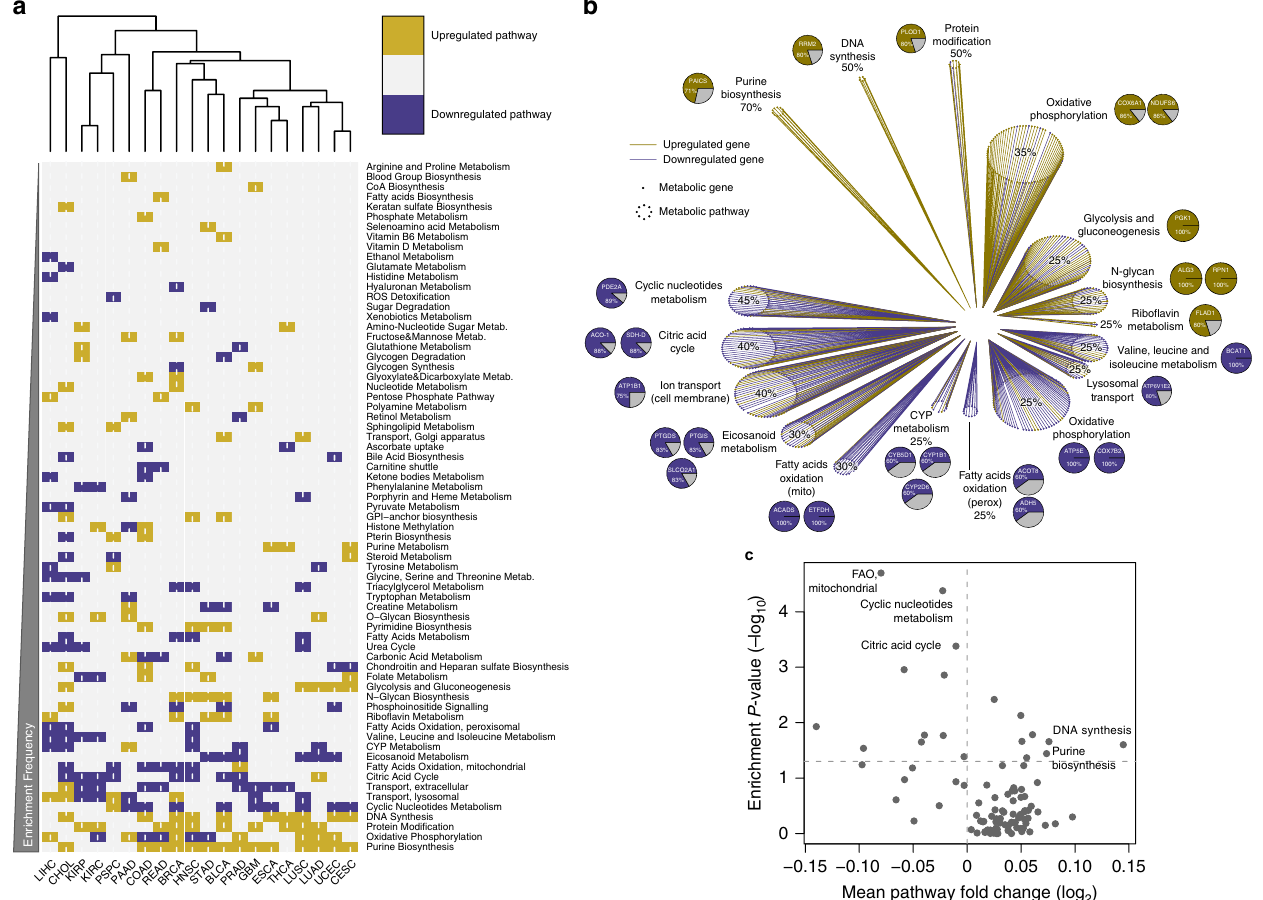
Figure 1 | Rewiring of metabolic gene expression in cancer tissues compared to normal. ( a ) Heatmap representation and hierarchical clustering of enriched upregulated (gold) and enriched downregulated (blue) metabolic pathways in cancers compared to normal tissues. ( b ) Gene expression effect plot of metabolic pathways enriched in more than 25% of cancers. Circles indicate metabolic pathways and dots in each circle represent individual metabolic genes. Gold and blue lines indicate upregulated and downregulated genes in cancers compared to normal tissues, respectively. Pie charts represent the most frequently up- or downregulated genes in the corresponding pathway; percentage values indicate frequency of up- or downregulation. ( c ) Volcano plot representation of mean fold change expression of genes in each pathway ( x axis) vs enrichment P -values ( y axis) in breast cancer vs normal samples (data obtained from Terunuma et al. 8 ). Significantly enriched metabolic pathways in common with Fig. 1b are indicated. NATURE COMMUNICATIONS|7:13041|DOI: